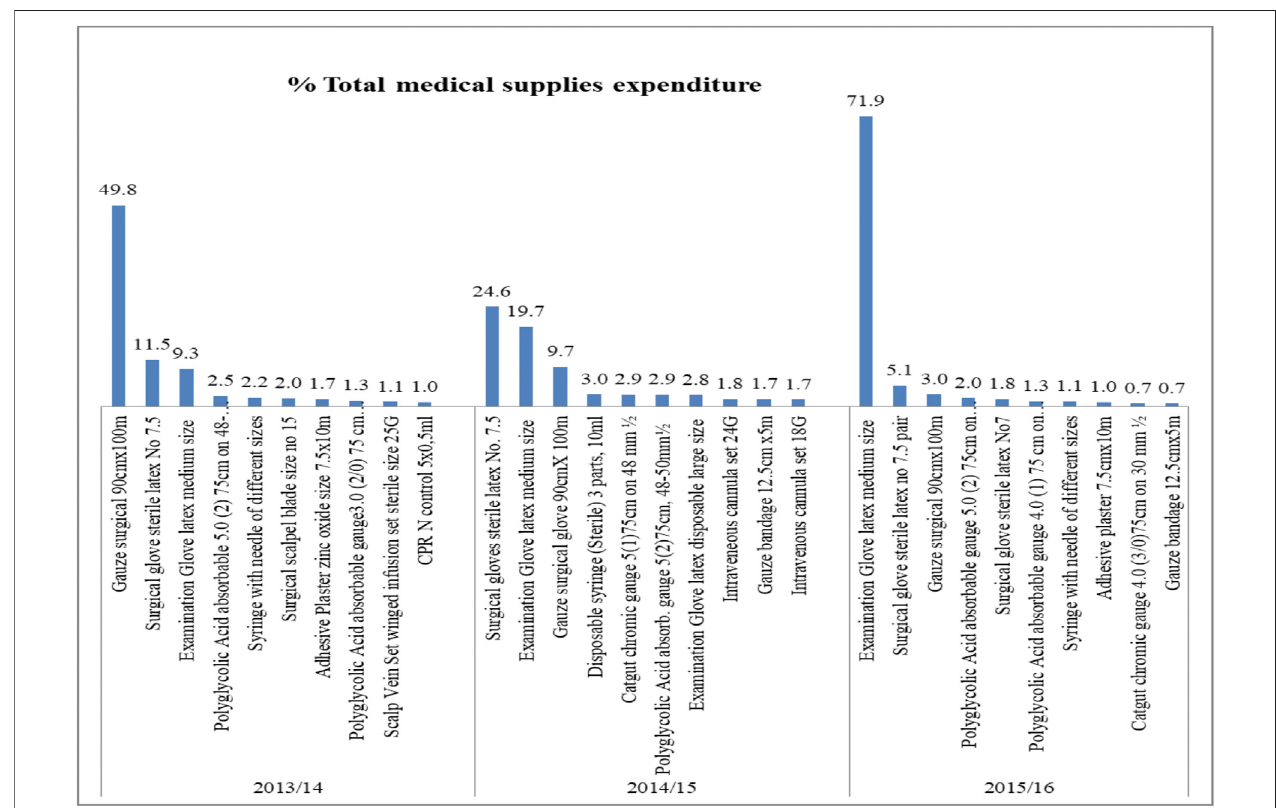
FIGURE 6 | Top ten (based on cost) class “ A ” medical supplies in SPHMMC (2013/14 – 2015/16), March 2017.